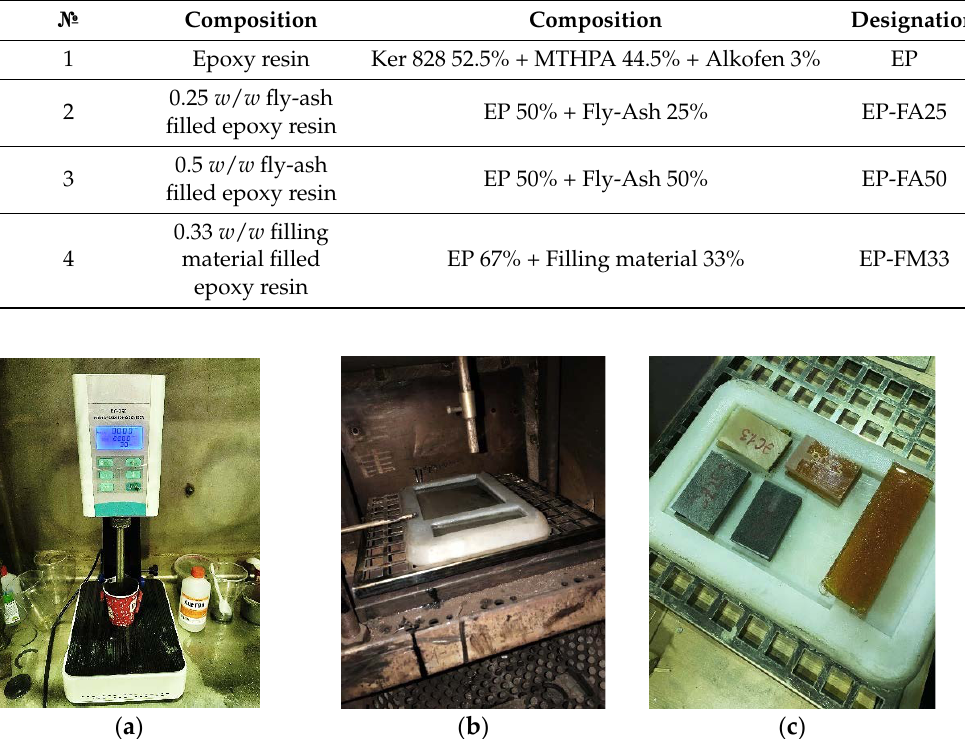
Figure 2. Sample preparation: ( a ) mixing in a homogenizer; ( b ) curing in a laboratory oven in a silicone mold; ( c ) prepared samples.